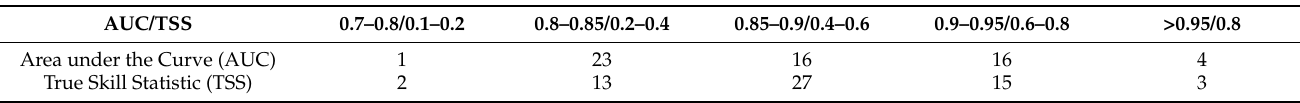
Table 2. Comparison of area under the Receiver Operating Characteristic (ROC) curve (AUC) and true skill statistic (TSS) of the MaxEnt model.